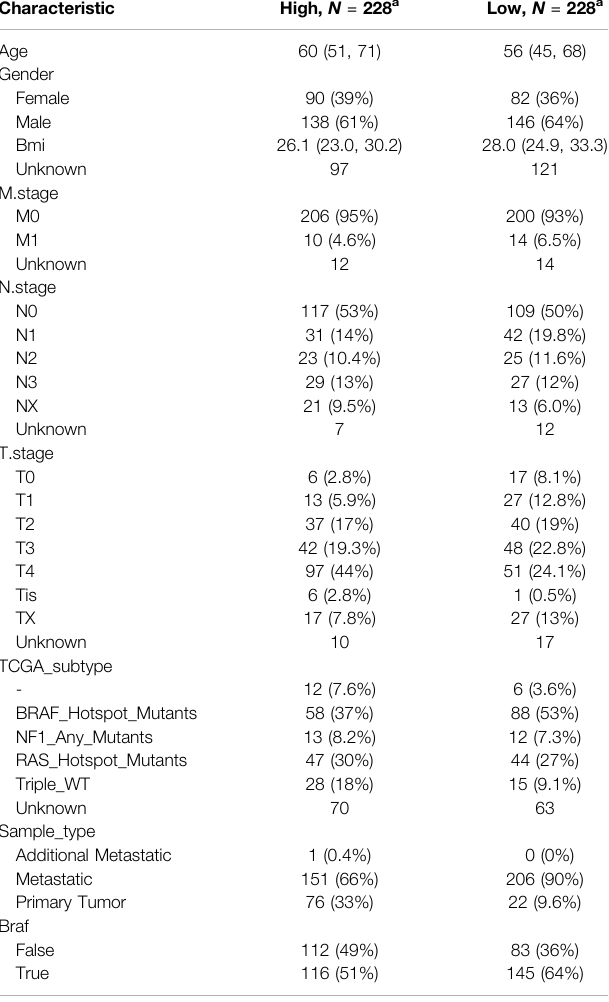
TABLE1| Characteristicsofpatientsinlow-andhigh-riskscoresinTGGAcohort.